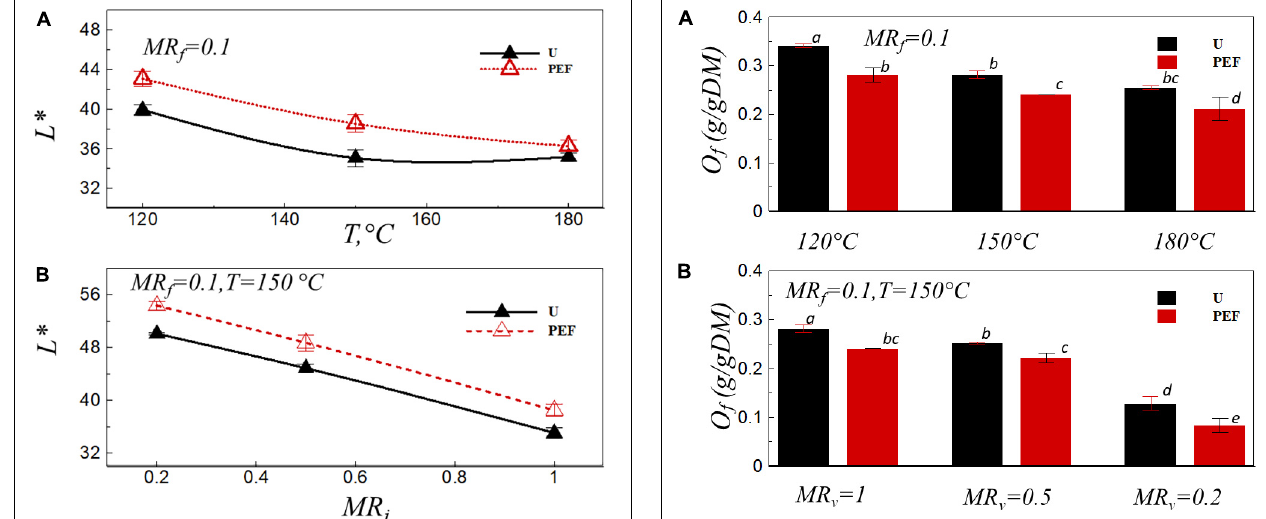
FIGURE 4 | Lightness value, L ∗ , after frying with the final moisture ratio of the sample, MR f = 0.1, vs. the frying temperature (A) , and the moisture ratio after VD (B) for untreated (U) and PEF pre-treated samples (PEF).